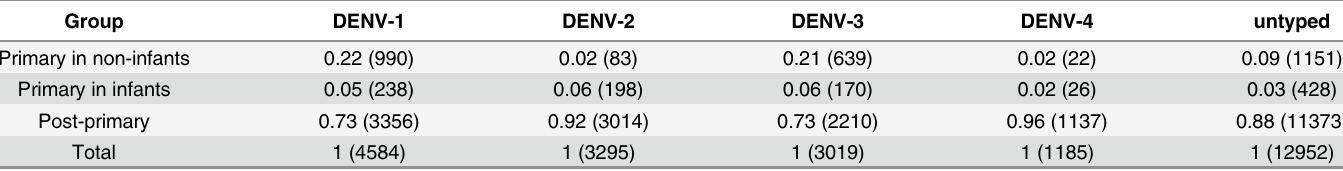
Table shows proportions of cases in each group that are of each serotype. Case numbers are in brackets. The accompanying fi gure, with the data by year, is Fig